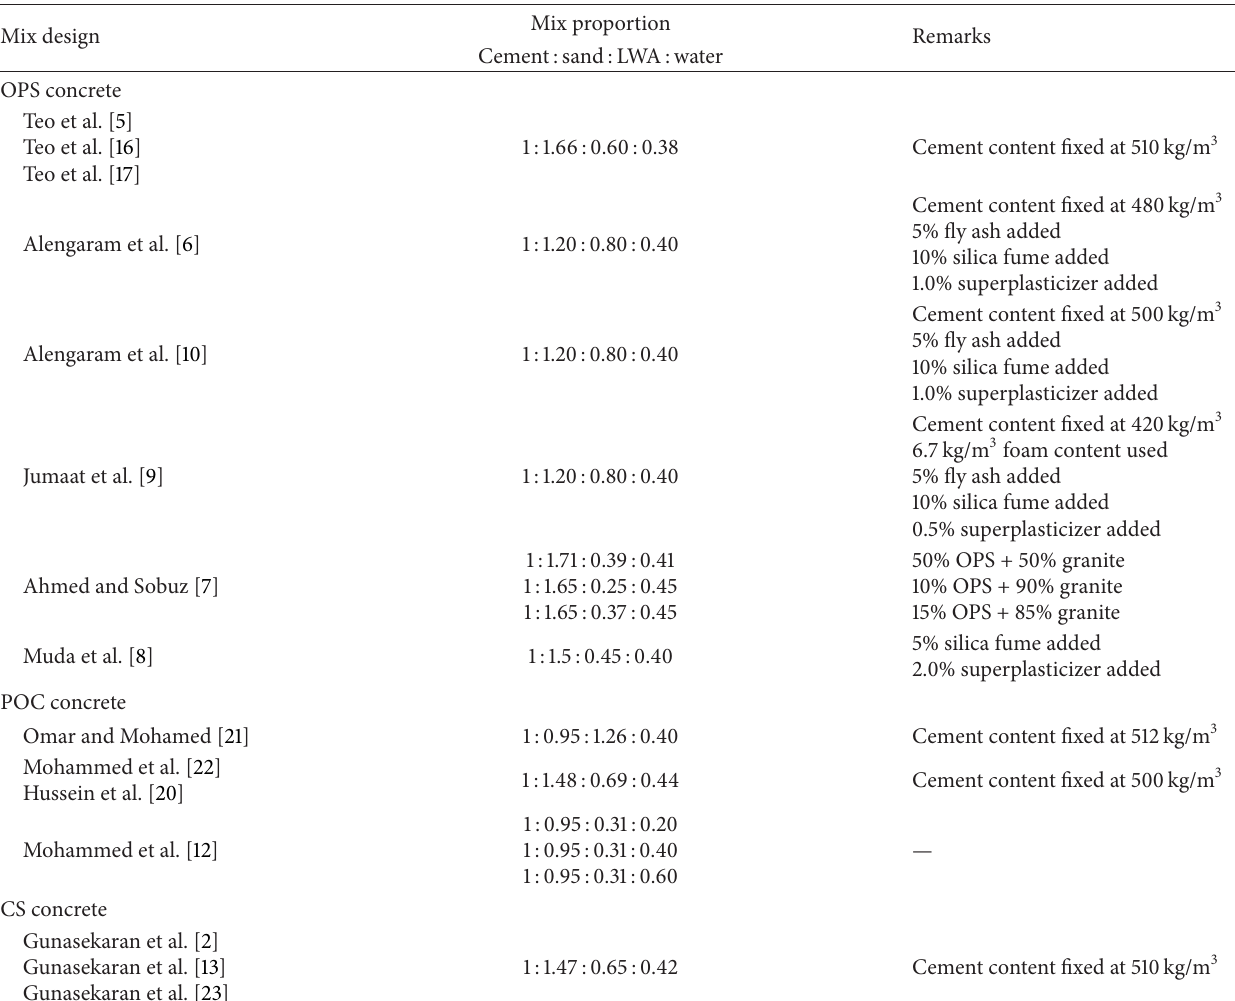
Table 1: Mix design for LWC in reinforced concrete